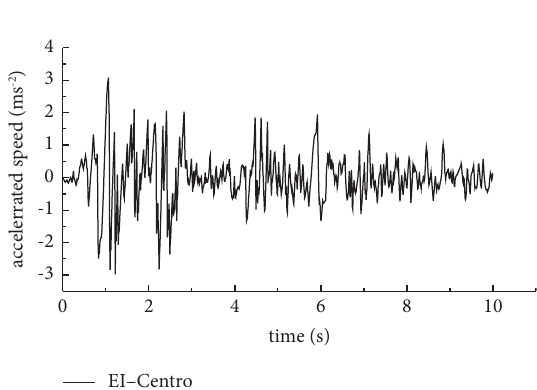
Figure 7: EI-Centro acceleration time-history